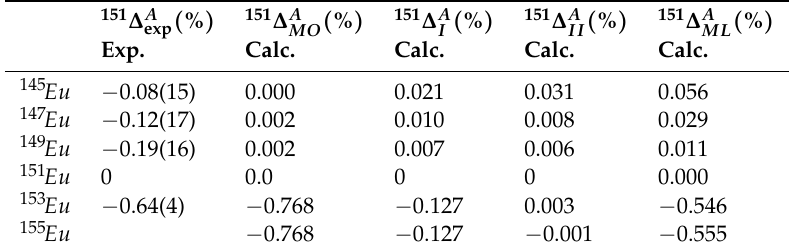
Table 3. Hyperfine anomaly in Eu, experimental and calculations. MO denotes values obtained from Particle-rotor calculations, I and II values from [23], and ML values obtained from the Moskowitz–Lombardi formula [24].